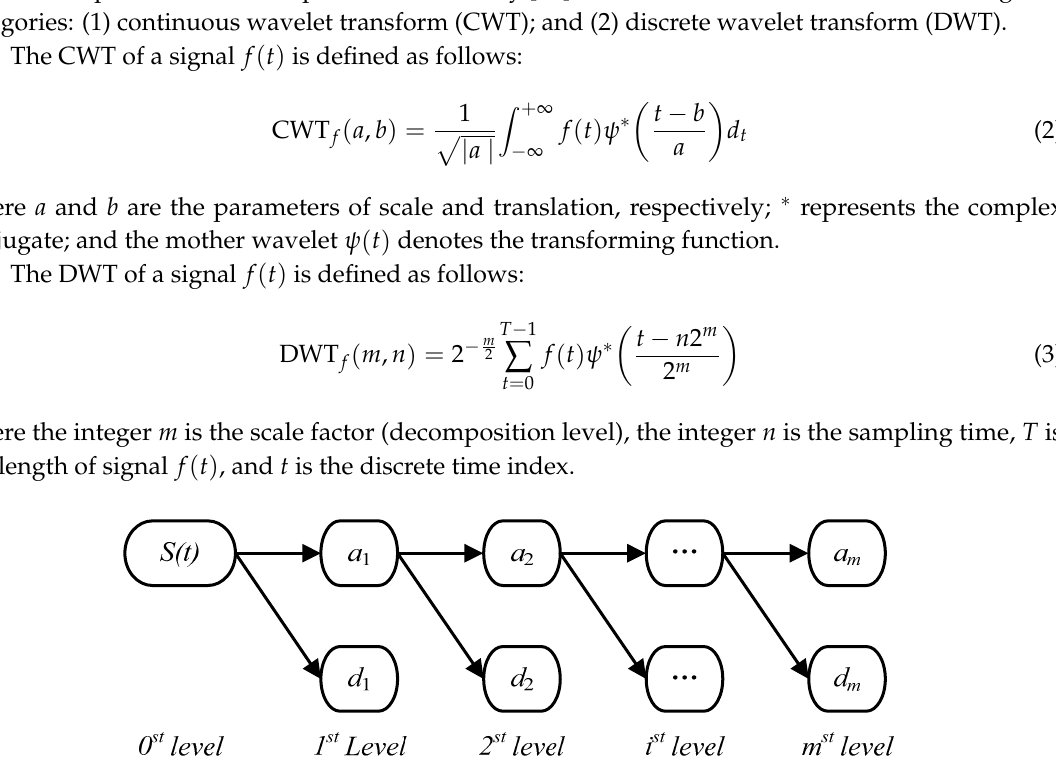
Figure 1. The process of m -level decomposition by WT for time series